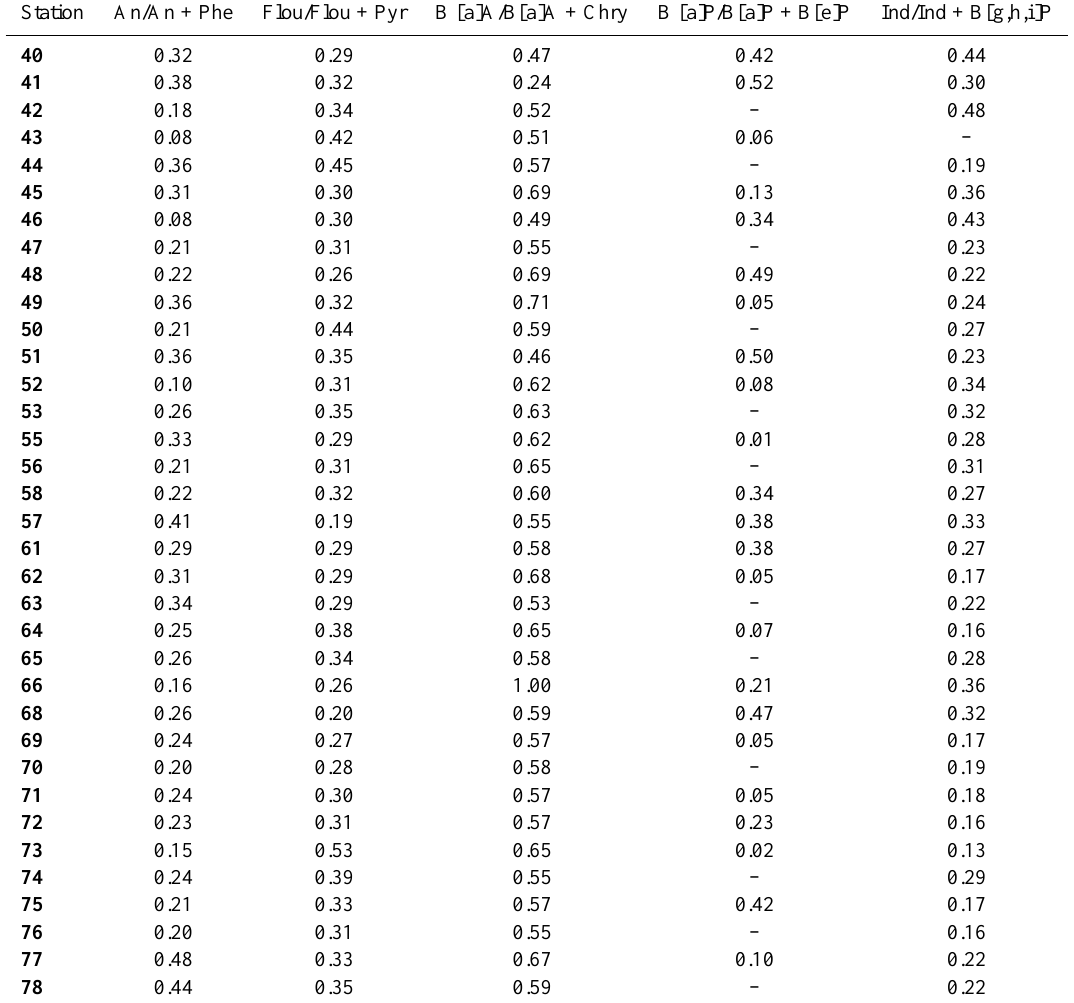
Table A6. Five of Diagnostic ratios of Khao Lak sediments